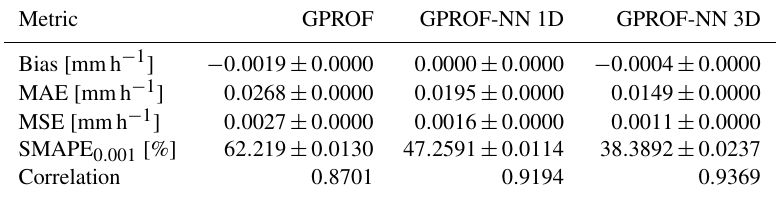
Table C8. The same as Table 5 but for